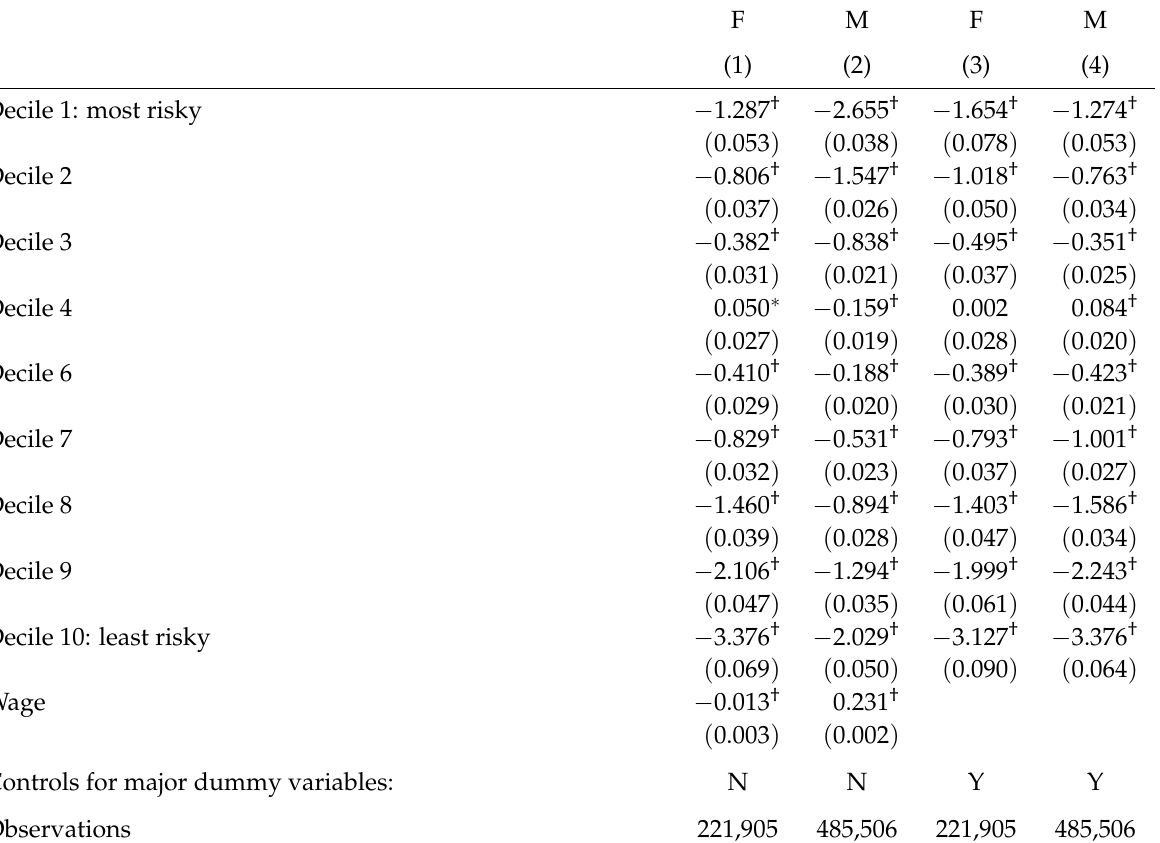
Table 3: Unidimensional Preferences Model: Effects of Expected Wage and Difficulty of Being Accepted, by Gender, on the Ranked Choice,